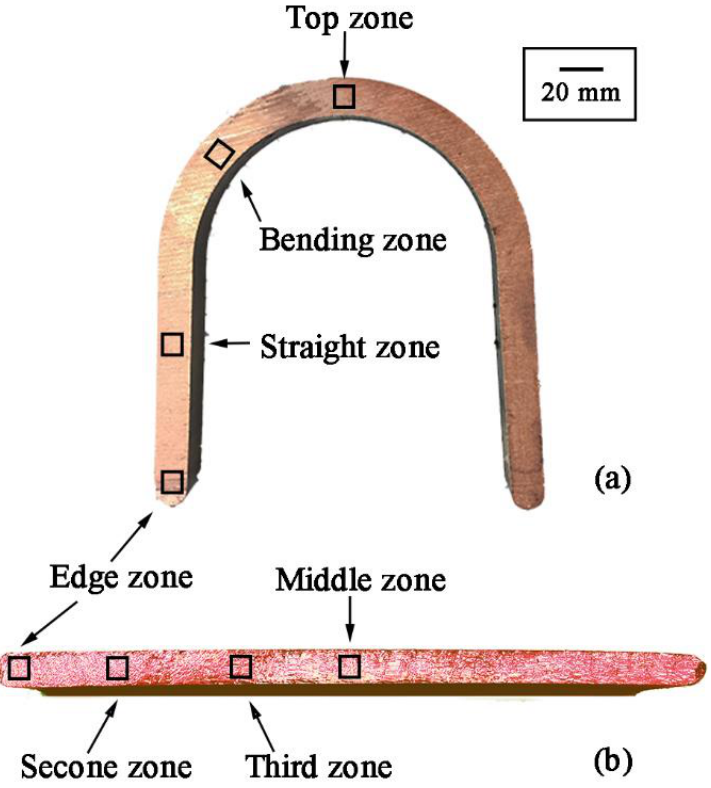
Figure 3. Areas marked on the cross-section of the product: ( a ) U-Shaped strips, ( b ) Flat strips.